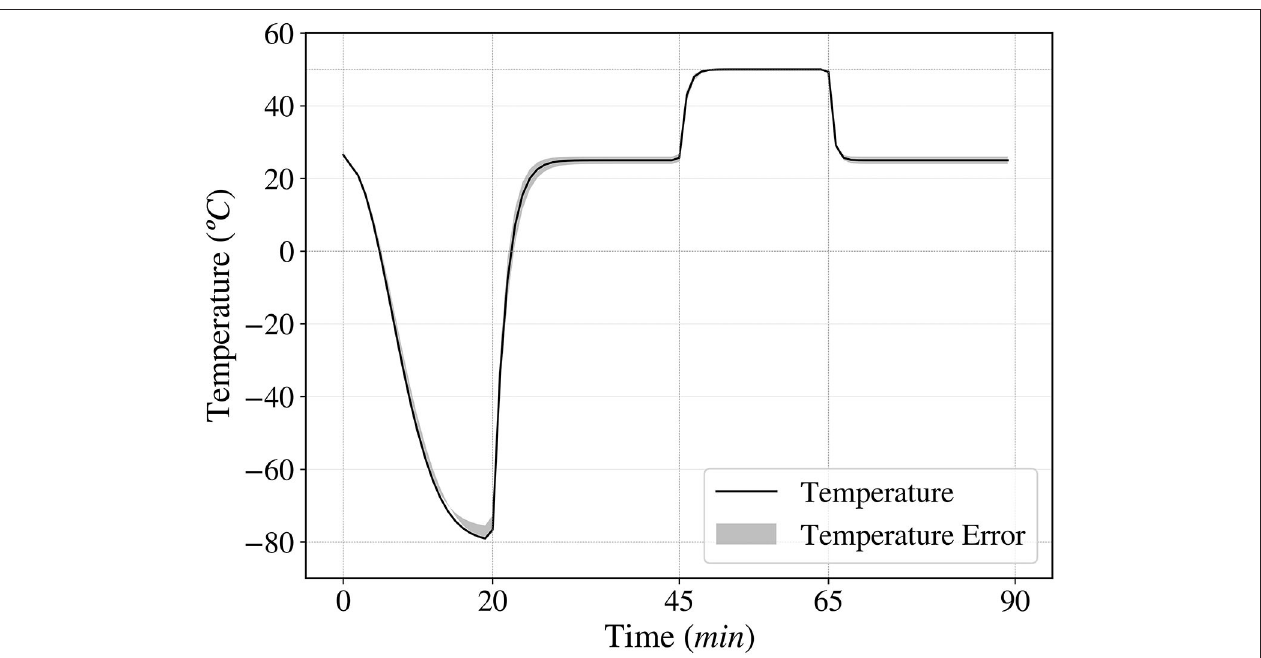
FIGURE 3 | Temperature fluctuation over time in one cycle, ranging from –80 to 50 ◦ C. A complete cycle consists of 20 min at –80 ◦ C, 25 min at room temperature, 20 min at 50 ◦ C and 25 min at room